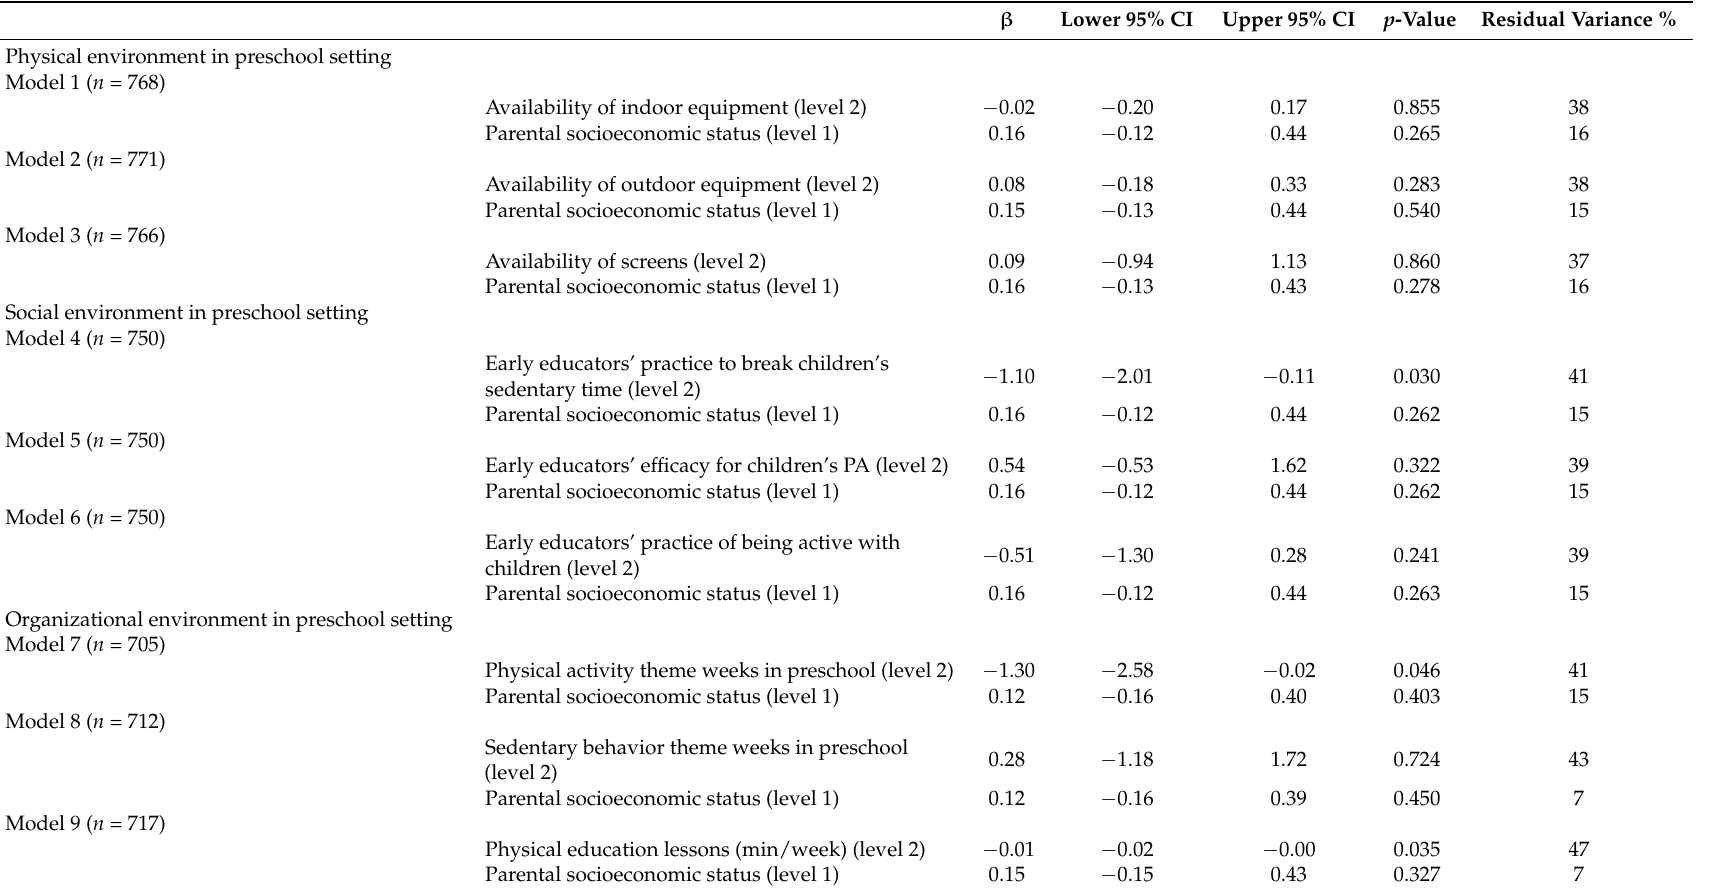
Table 2. The associations of parental socioeconomic status and preschool environmental factors with children’s sedentary time. β Lower 95% CI Upper 95% CI p -Value Residual Variance